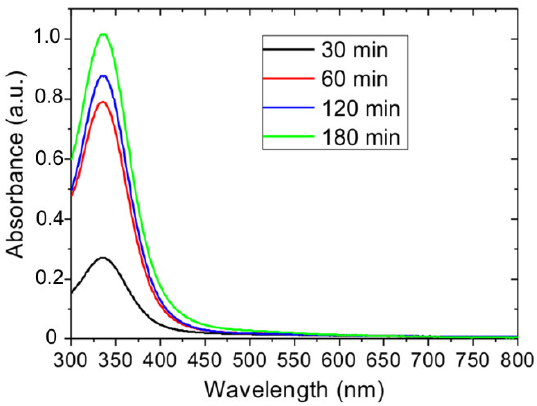
Figure 2. UV-Vis absorbance spectra of acid treated HT samples at 0.23 mg/mL initial concentration for different ultrasonication times.